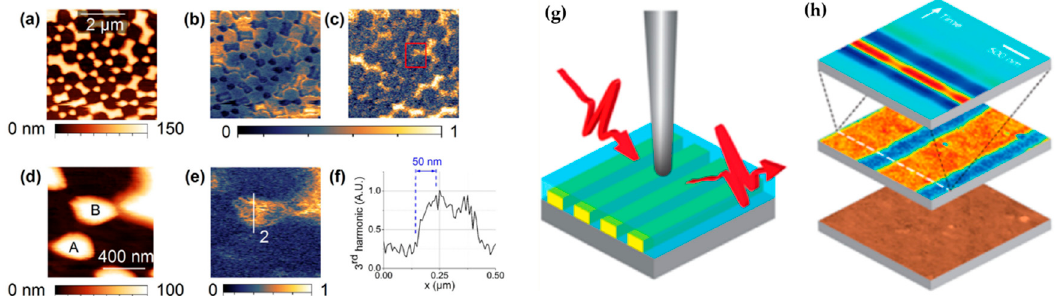
Figure 9. s-SNOM images of gold islands measured with a free-electron laser at 1.3 THz: ( a ) AFM topography; ( b ) near-field image referenced to the 2nd harmonic; and ( c ) the 3rd harmonic. ( d ) AFM topography and ( e ) the 3rd harmonic near-field image of the zoomed region indicated in ( d ). ( f ) Line scan over the gold structure indicated in ( e ). Reprinted with permission from [132]. ( g ) Illustration of THz s-SNOM imaging of the embedded gold grating and ( h ) the resulting images of AFM topography, THz peak field image and corresponding waveforms along the white line (bottom to top). Reprinted with permission from [134].